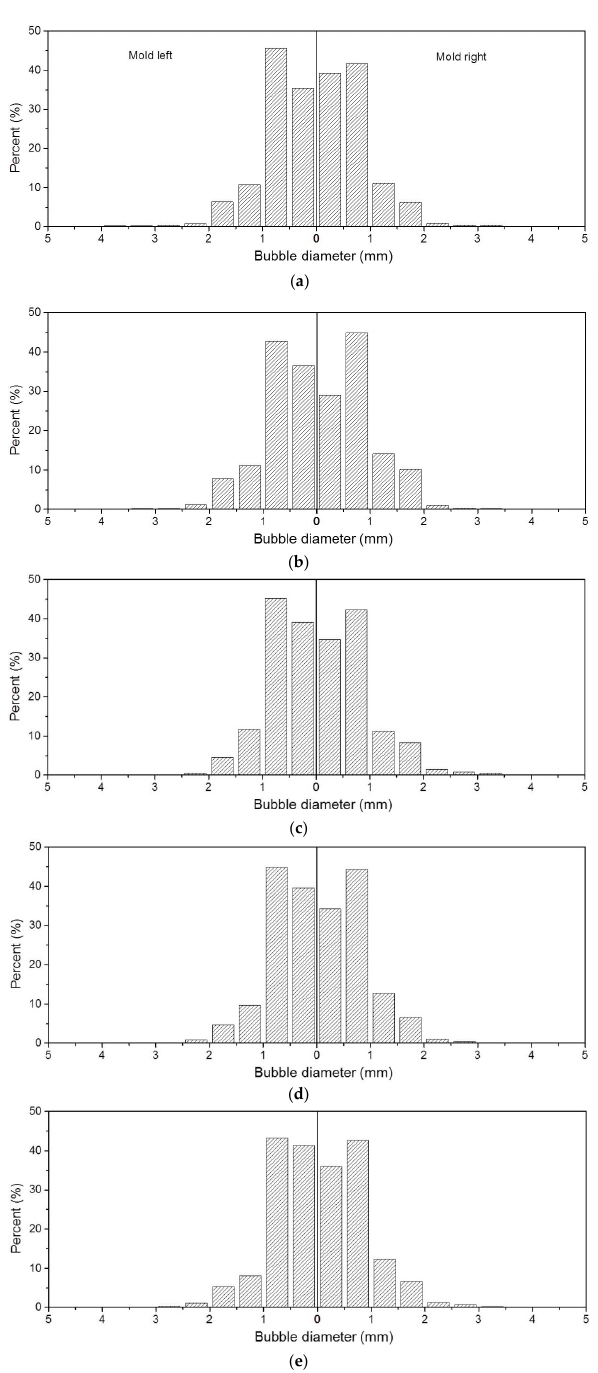
Figure 13. Size distribution of bubbles along the wide face of the mold: ( a ) 30 mL·min − 1 , ( b ) 60 mL·min − 1 , ( c ) 90 mL·min − 1 , ( d ) 160 mL·min − 1 , ( e ) 190 mL·min − 1 .